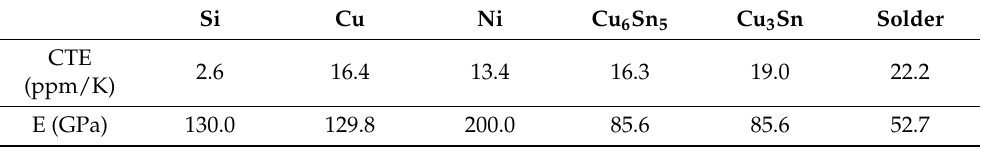
Table 1. Material properties used in this study. CTE: coefficient of thermal